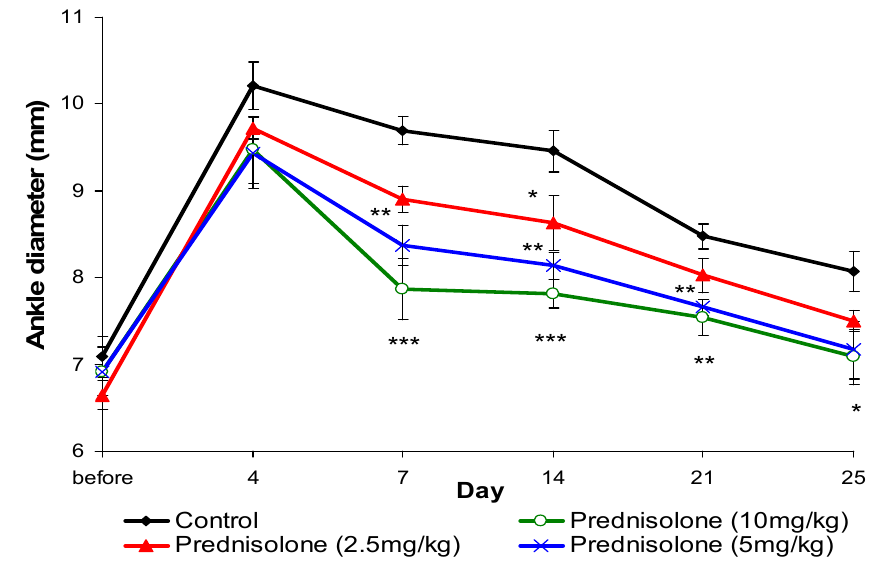
Figure 4. Anti-inflammatory effect of prednisolone on FCA-induced arthritic rats. (N =